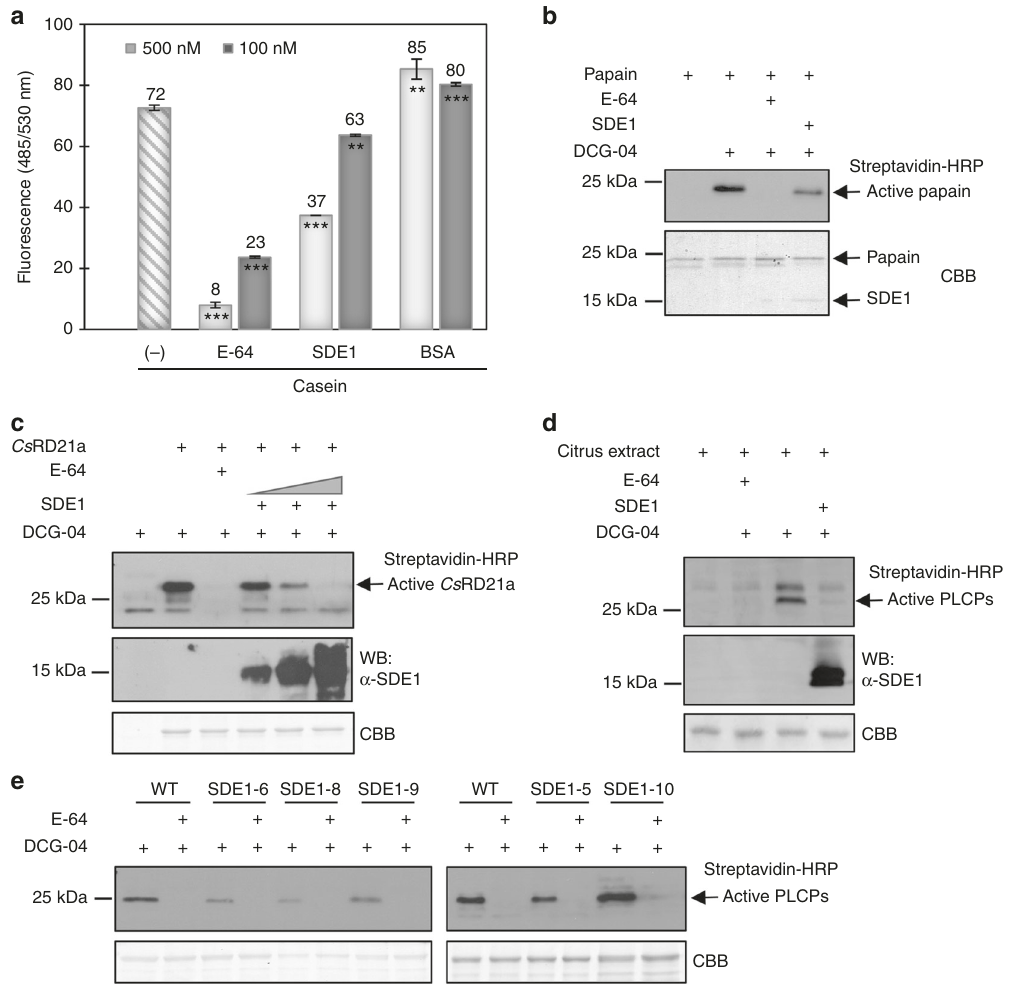
Fig. 2 SDE1 inhibits PLCP activity in vitro and in plant cells. a Proteolytic activity of papain measured by digestion of a fl uorescent casein substrate in the presence of E-64, puri fi ed SDE1 protein, or BSA (as a negative control). Fluorescence was measured at 485/530 nm excitation/emission. Mean ± standard deviation ( n = 3) is shown. Asterisks (*) indicate statistically signi fi cant differences based on the two-tailed Student ’ s t -test. p < 0.01 = **, p < 0.001 = ***. b Inhibitory effect of SDE1 on the protease activity of papain examined by activity-based protein pro fi ling (ABPP). Active papain was labeled by DCG-04 in the presence of 10 μ M E-64 or 1.6 μ M puri fi ed SDE1 protein and detected using streptavidin conjugated with horseradish peroxidase (HRP). c SDE1 inhibits the activity of Cs RD21a. Cs RD21a-Flag (with its N-terminal secretion signal) was expressed in N . benthamiana . Active protease in the apoplastic fl uid was labeled via ABPP. ImageJ analysis of the signal intensity revealed approximately 9%, 62%, and 96% reduction of Cs RD21a activity in the presence of 0.8, 1.6, or 3.2 μ M puri fi ed SDE1 protein, respectively. d SDE1 inhibits PLCP activity in citrus. Total protein extracts from Navel orange ( C . sinensis ) leaves were labeled via ABPP in the presence of 120 nM puri fi ed SDE1 protein. Active proteases were enriched using streptavidin beads and detected using streptavidin- HRP conjugates. e Transgenic grapefruit (Duncan) seedlings expressing SDE1 exhibit reduced protease activity. Five individual lines were analyzed by